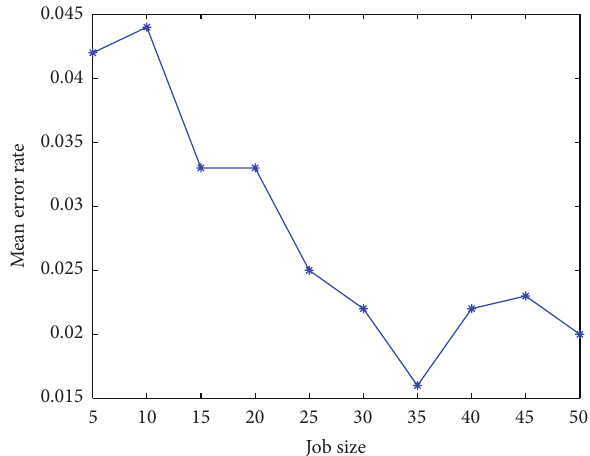
Figure 2: The mean error rate of the HA for 1|𝑝 𝑖𝑟 , rm |𝐶 max .